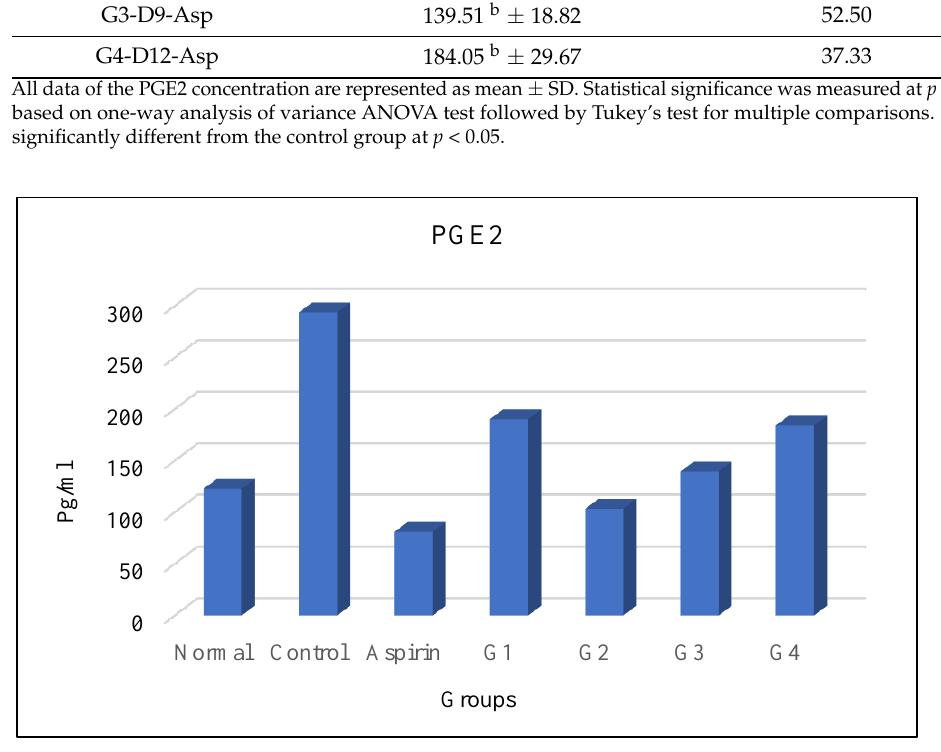
Figure 12. The effect of the tested dendrimers on serum levels of PGE2 in rats.